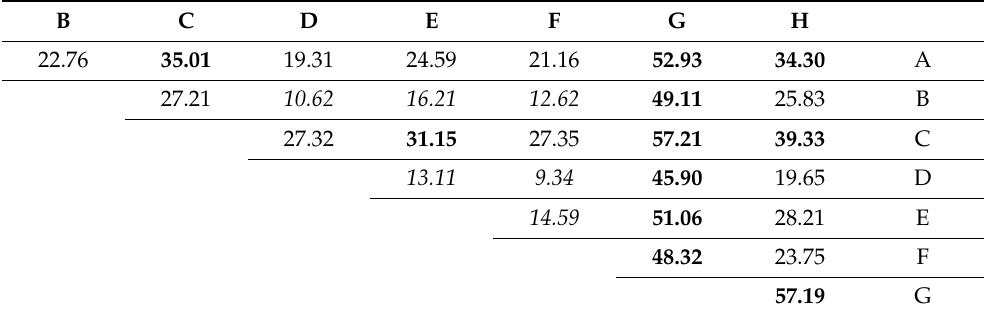
Table 7. Values of %EV